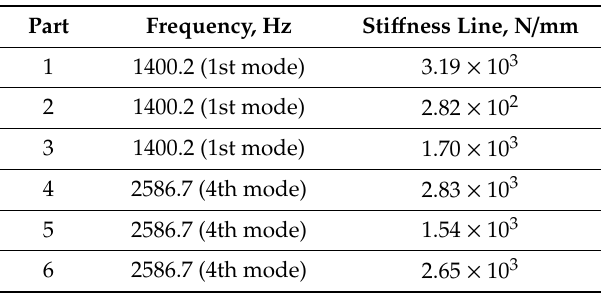
Table 5. Results of the local sti ff ness